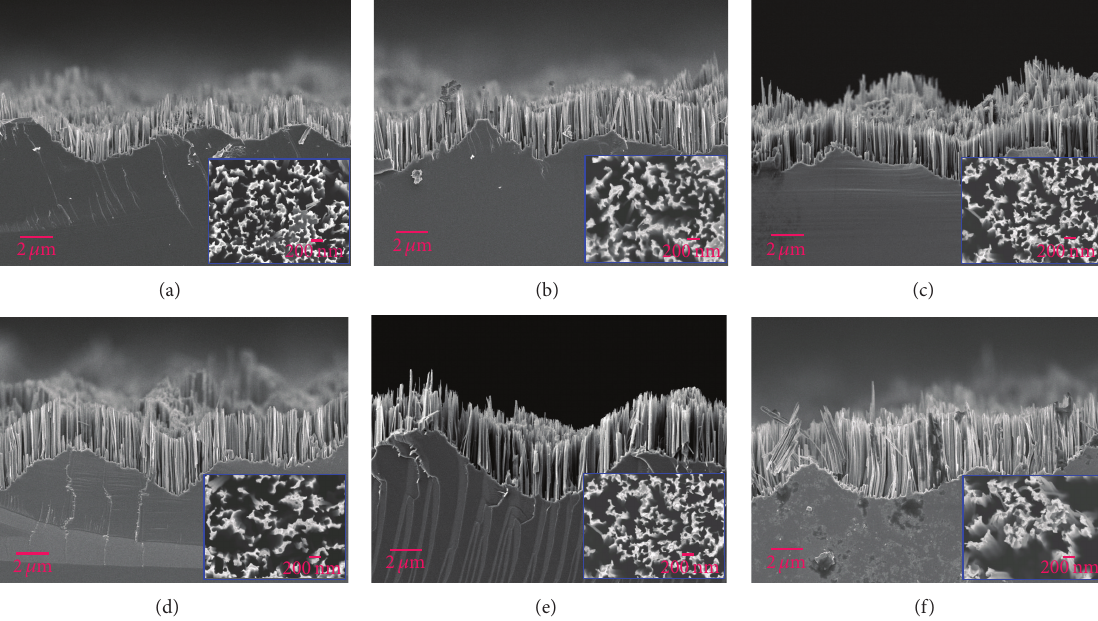
Figure 2: SEM images of micronanohybrid silicon substrates fabricated by combinations of a fixed second-stage processing time (5 min) and various first-stage processing times: (a) 20 sec, (b) 25 sec, (c) 30 sec, (d) 35 sec, (e) 40sec, and (f)